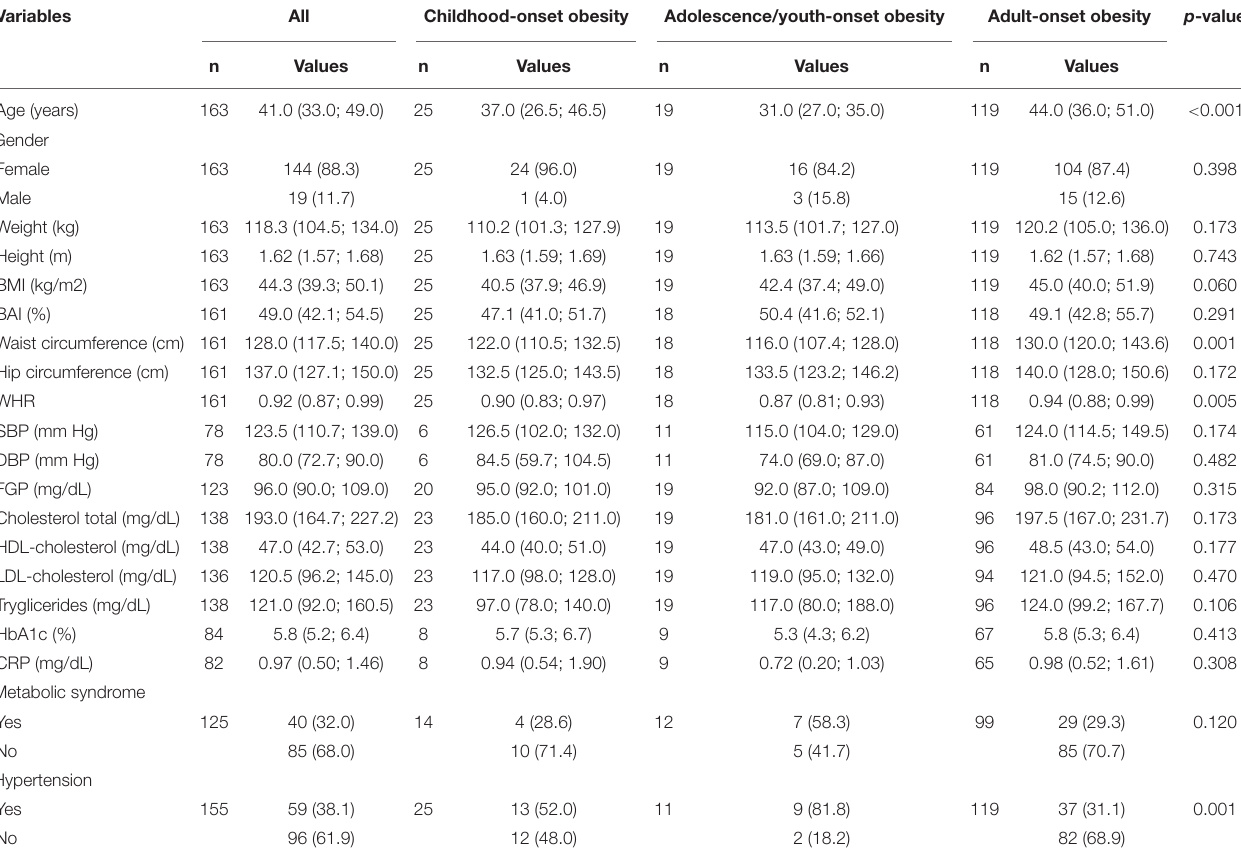
TABLE 1 | Anthropometric and serum biochemistry profile characterization of the study cohort according to onset obesity. Variables All Childhood-onset obesity Adolescence/youth-onset obesity Adult-onset